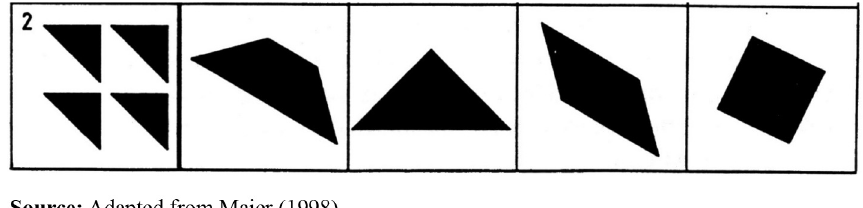
Figure 1. A typical question on 2D